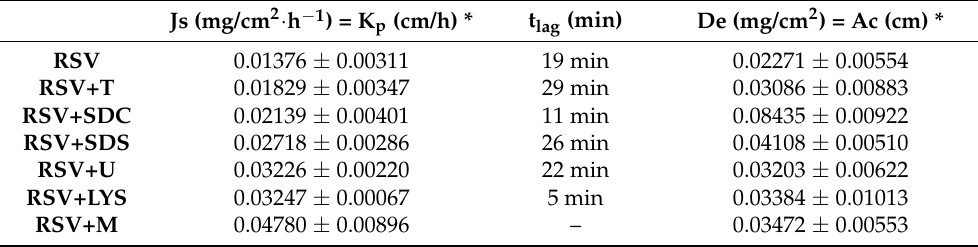
Figure 3. Amount (mg) of RSV accumulated in the sublingual tissue after 3 h by administering RSV solution 1 mg/mL (black) and RSV solution 1 mg/mL + 0.2 mg/mL of sodium dodecylsulfate (red), sodium dehydrocolate (blue), Transcutol ® (pink), lysine hydrochloride (orange), urea (light blue) and menthol (green). Results are presented as means ± SE ( n = 6). Table 3. Extrapolated RSV biopharmaceutical parameters (Js, Kp, t lag , De and Ac) in the absence or in the presence of the selected CPEs. Values are presented as means ± SE ( n =